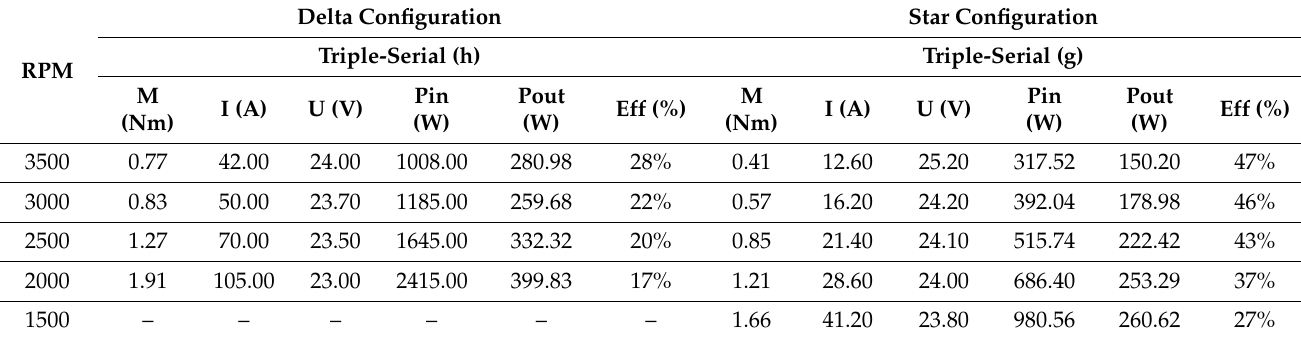
Table 3. Measured results of big delta/big star winding interconnections. Delta